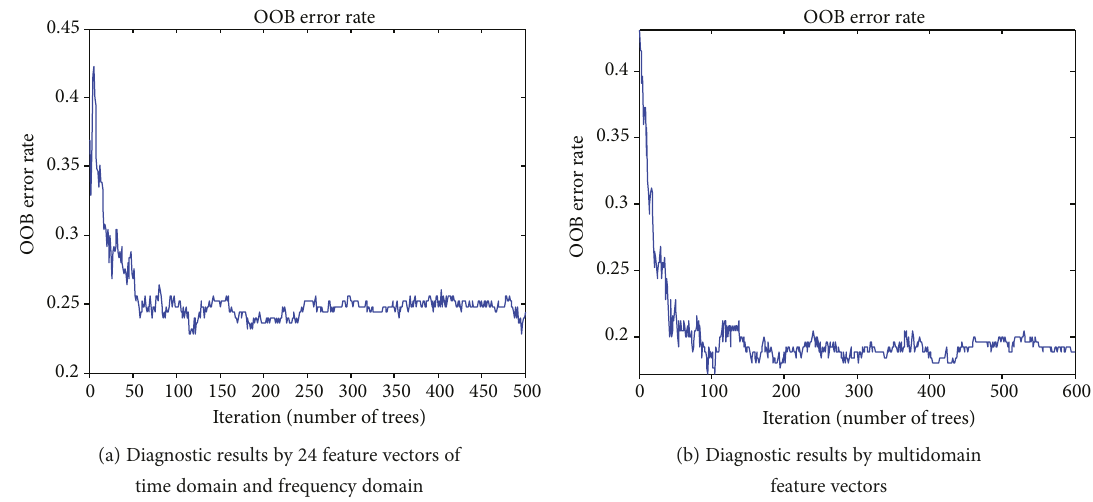
Figure 11: Diagnostic results under di ff erent load conditions of the same fault.